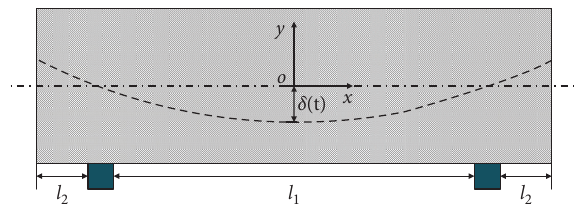
Figure 6: The deflection curve of falling weight